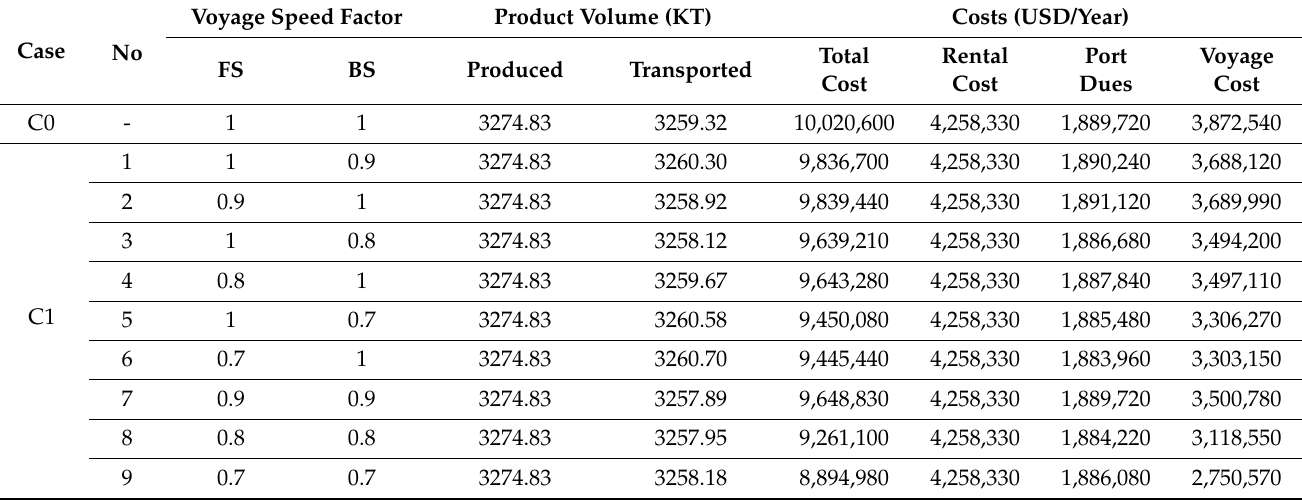
Table 6. Impact of lowering voyage speed with the current number of